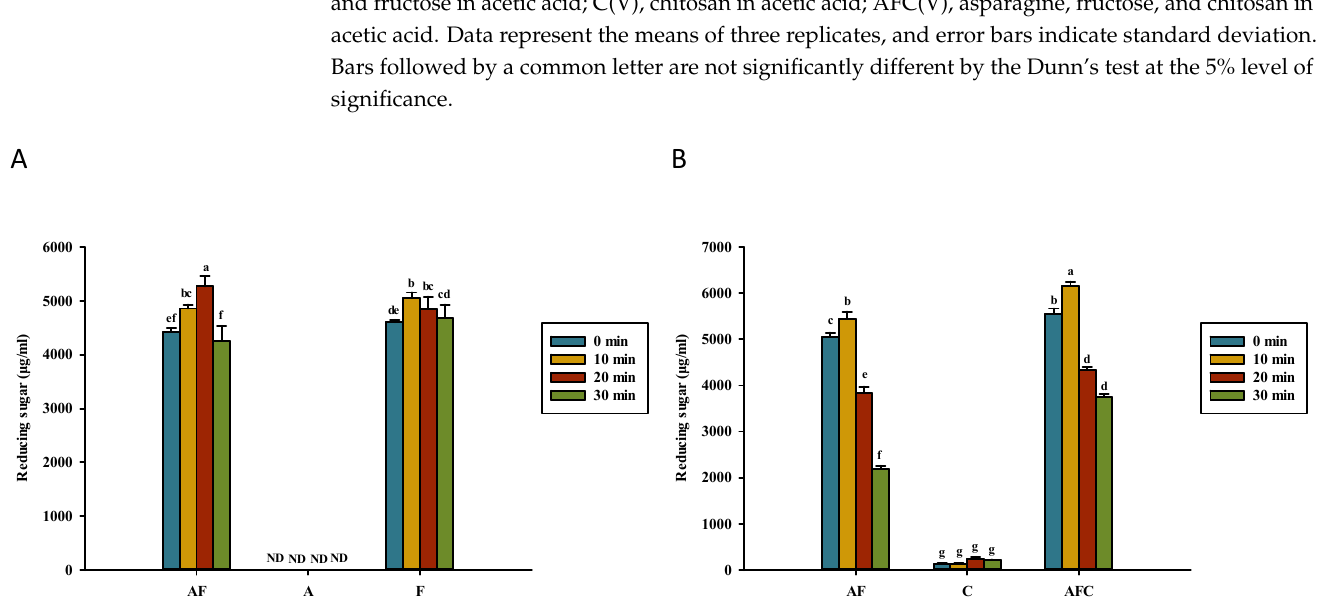
Figure 6. Reducing sugar concentration for various groups upon heating in ( A ) water and ( B ) acetic acid. AF, asparagine and fructose; A, asparagine; F, fructose; C, chitosan; AFC, asparagine, fructose and chitosan. Data represent the means of three replicates, and error bars indicate standard deviation. Bars followed by a common letter are not significantly different according to the Dunn’s test at the 5% level of significance (ND, not detected).